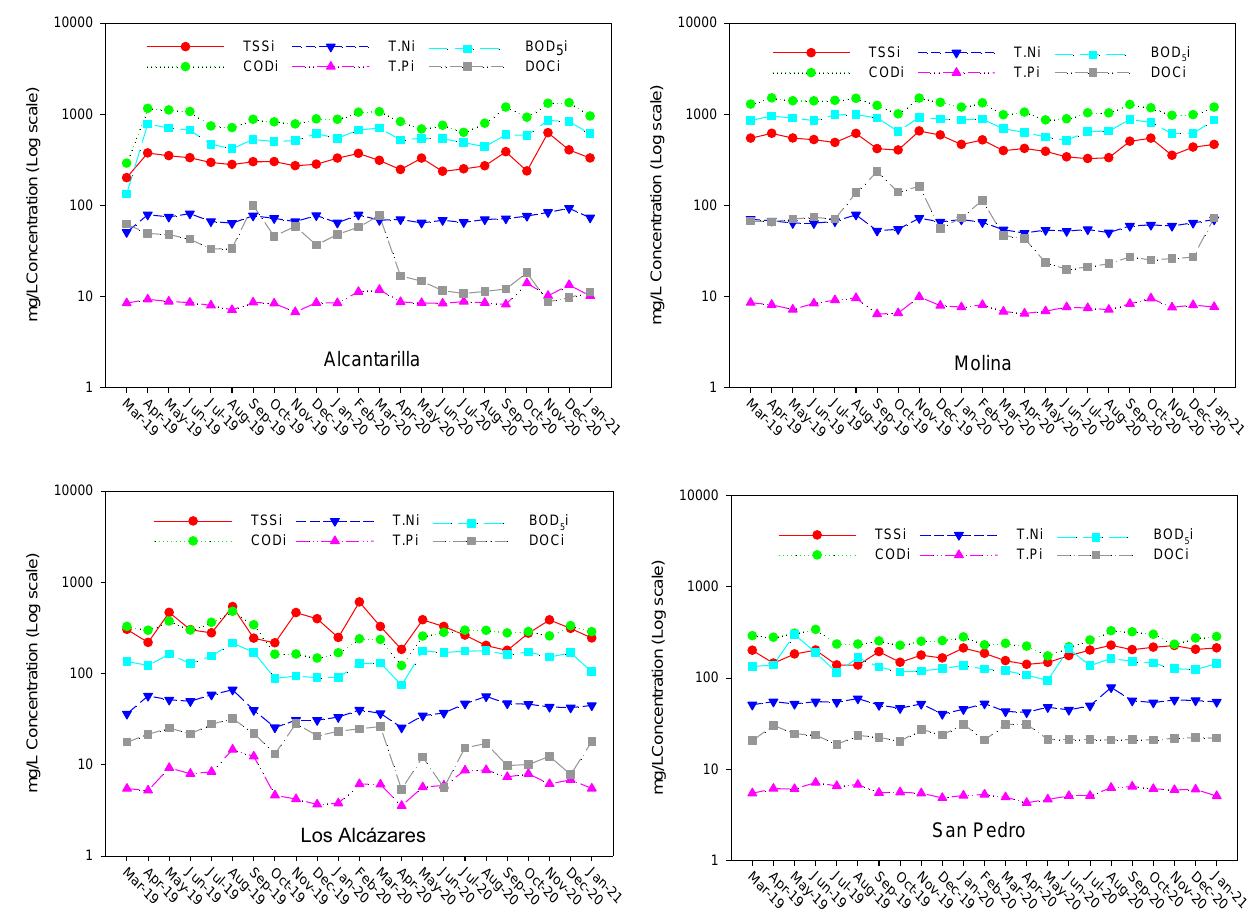
Figure 2. Temporal variation of average monthly influent (i) parameters.